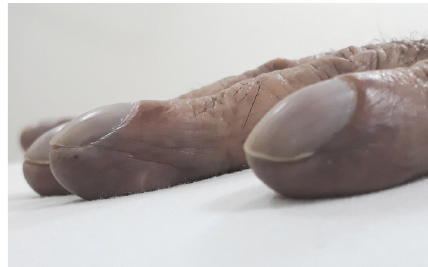
Figure 2: Digital clubbing.